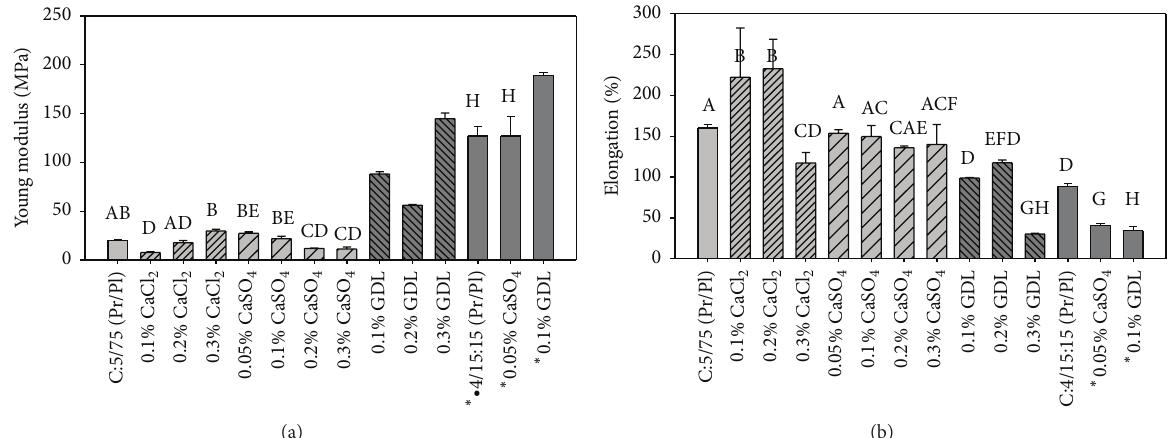
Figure 5: Young’s modulus (a) and elongation percentage (b) of films prepared with formulations 5PC-75S and 4PC-15G/15S. Note: values in a column with different letters are significantly different at 𝑝 < 0.05